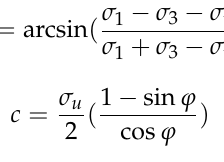
Figure 3. Equipment of triaxial tests.